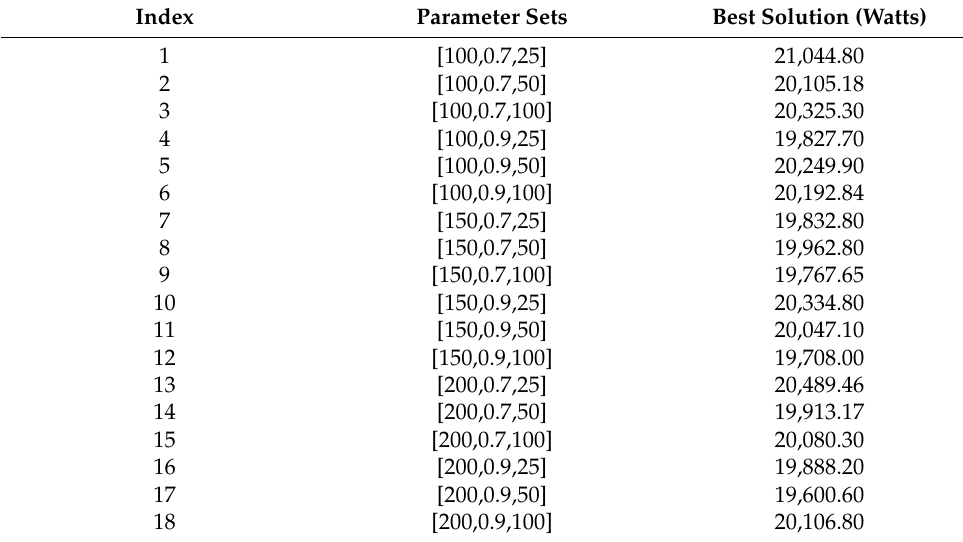
Table 3. Values of objective function for the best